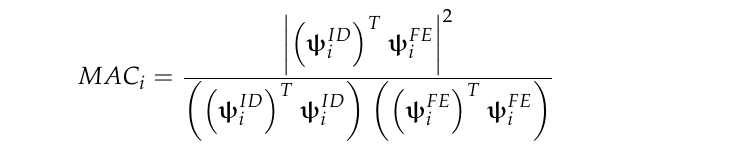
∈ R NDOF × 1 are the i th identified and FE-predicted mode The terms ψ ID and ψ FE i i shape vectors, respectively, and NDOF is the number of DOFs. The superscript T denotes matrix/vector transpose